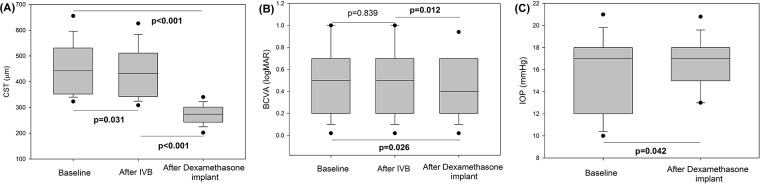
Box-and-whisker plots for central subfield thickness (CST), best-corrected visual acuity (BCVA), and intraocular pressure (IOP) changes in patients receiving dexamethasone implants due to poor responsiveness to 3 months of intravitreal bevacizumab (IVB) injections.The circles represent outliers. (A) CST was significantly reduced both after IVB injection and placement of dexamethasone implants. (B) BCVA did not improve significantly after IVB injection, but did upon dexamethasone treatment. (C) The baseline IOP was 15.52 ± 3.23 mmHg, and increased significantly to 16.61 ± 2.21 mmHg after placement of dexamethasone implants.